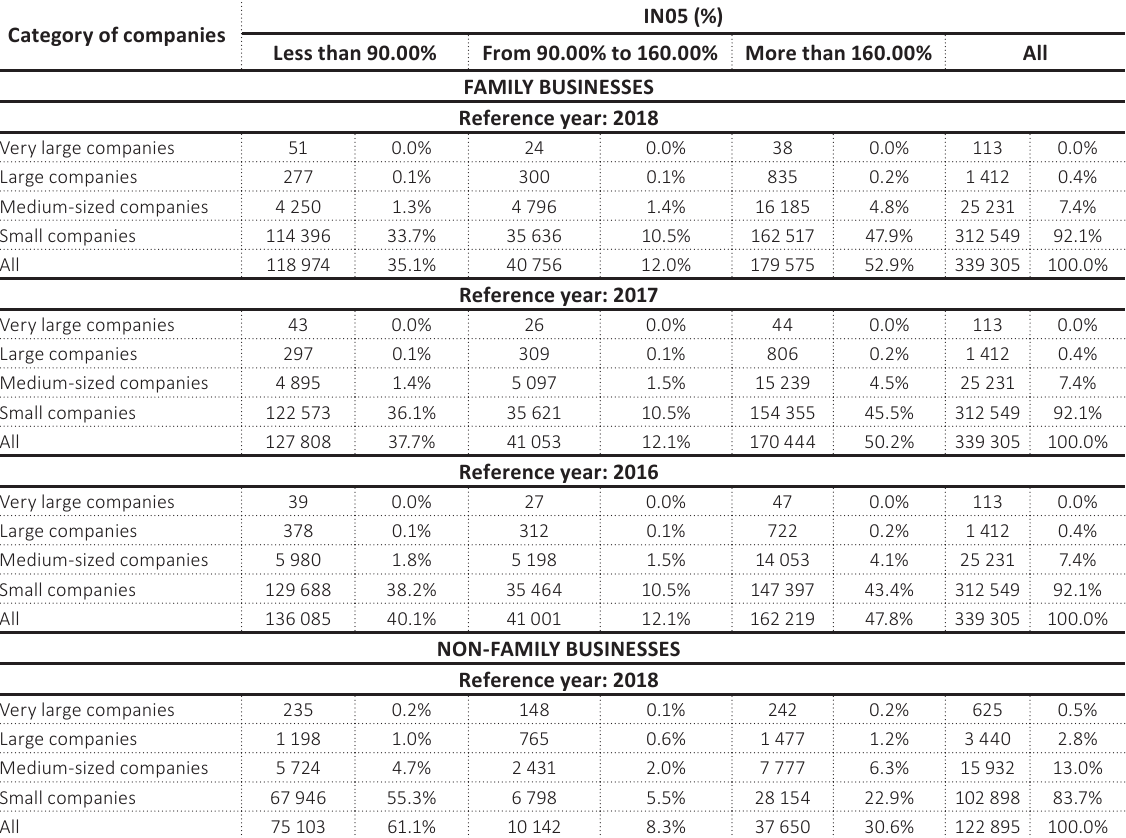
Table 4. IN05 values of the total of active Hungarian companies grouped by size and differentiated by